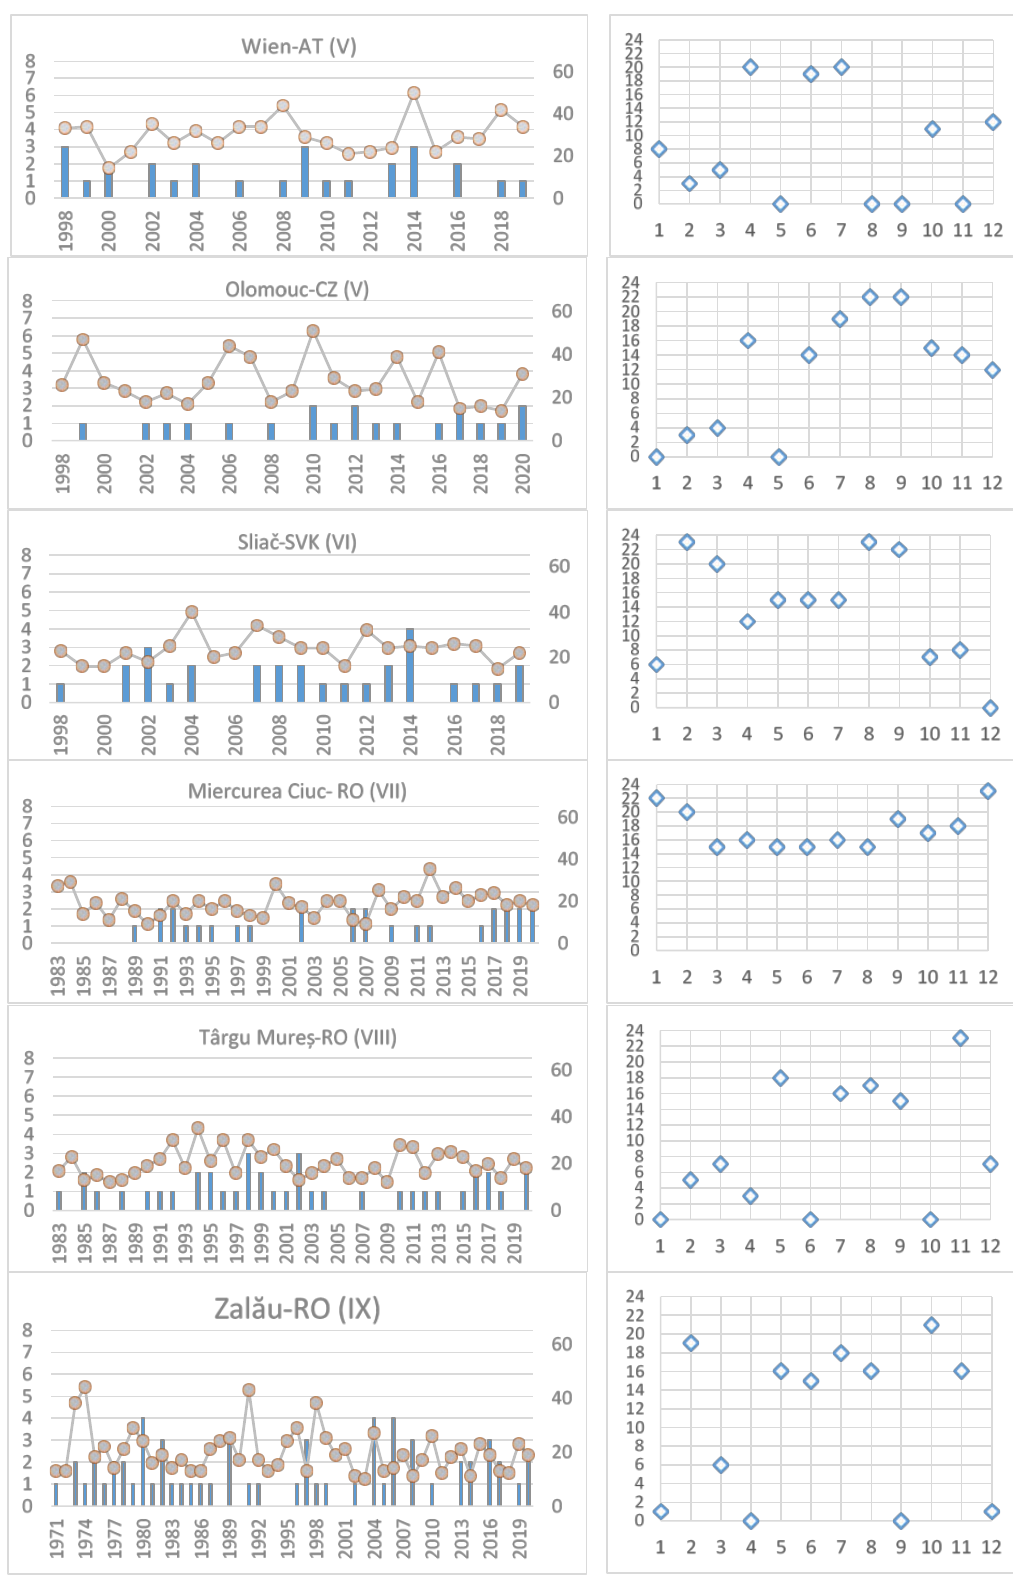
Figure 10. R3hr20mm (count of 3-h periods with greater than 20 mm; left panel, columns to the left axis) and MxLWS (Maximum length of wet spell, left panel, lines with marker to the right axis) and MoWH (timing of the wettest hour) on the right